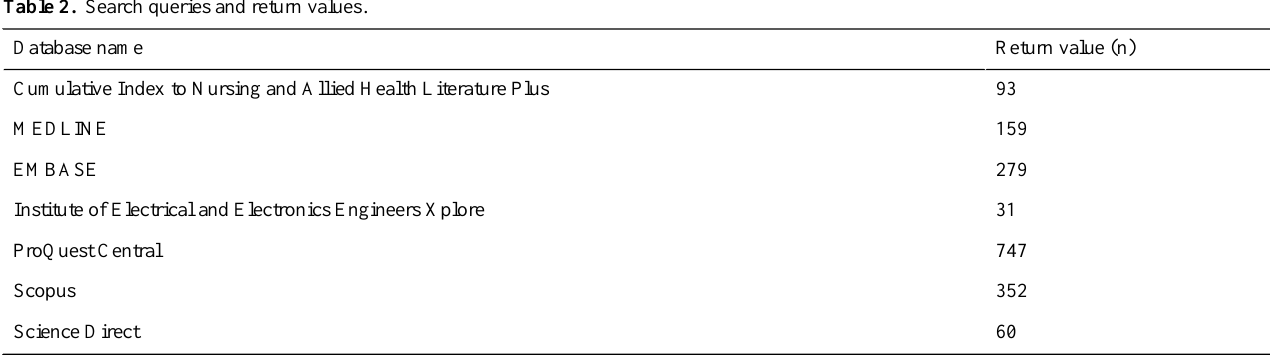
Table 2. Search queries and return